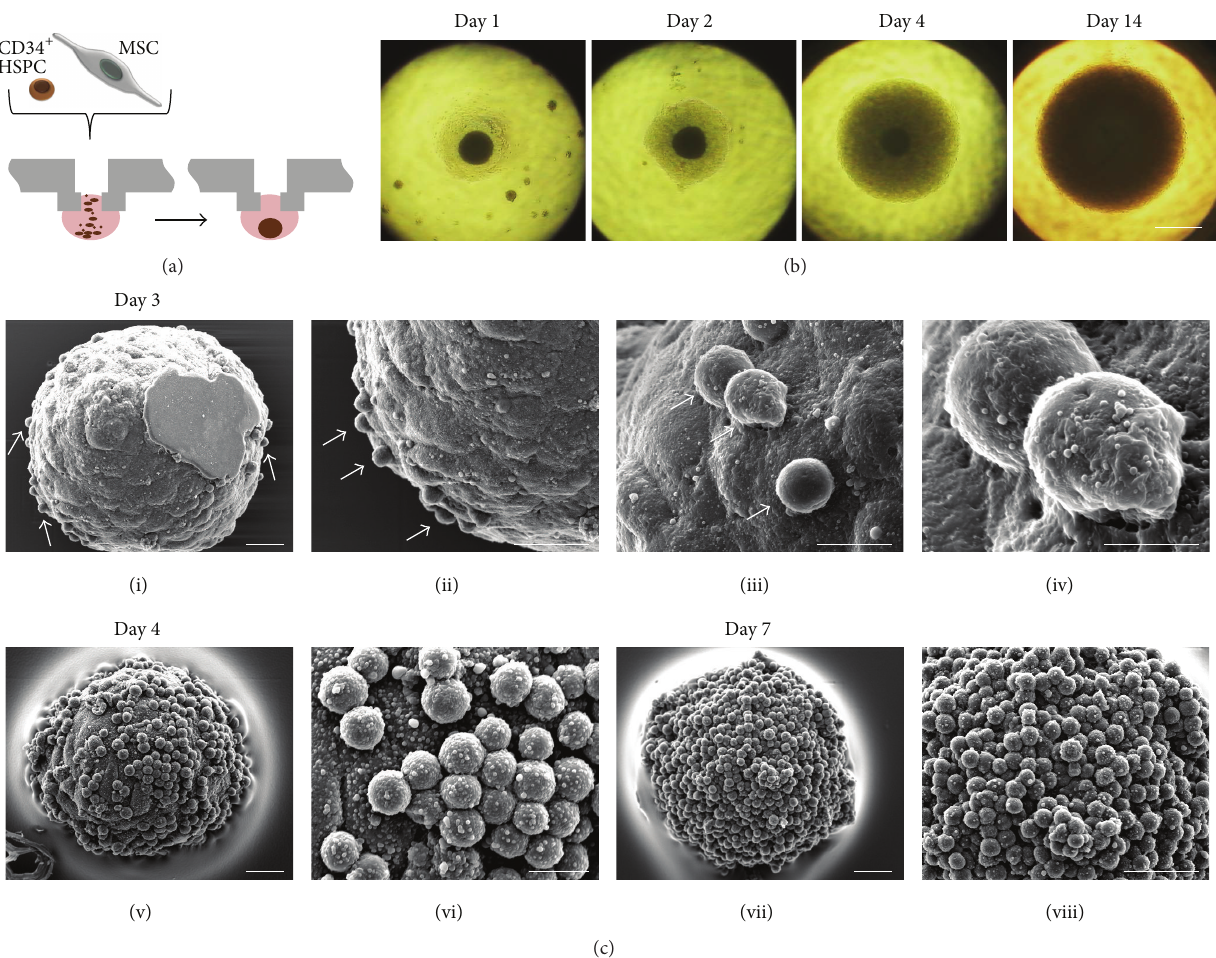
Figure 2: Attachment of CD34 + HSPCs to newly formed spheroids increases with time. (a) For coculture experiments, 5 × 10 2 CD34 + HSPCs were seeded together with 5 × 10 3 bone marrow MSCs per hanging drop and incubated for up to two weeks in GMP-SFEM-CC100 medium. (b) Light microscopy images depict the aggregation of MSCs into spheroids in the coculture as soon as one day after culture. Surrounding HSPCs expanded greatly over time. After 14 days, the cell density in the hanging drop was very high and the spheroid in the center became invisible. Scale bar: 500 𝜇 m. (c) Spheroids formed in cocultures were examined by scanning electron microscopy (SEM). A series of images from day 3 with increasing magnification (i–iv) shows a spheroid with only a few adhering HSPCs, identified as small round cells (arrows) attaching to the surface of the relatively smooth spheroid. On day 4, significantly more HSPCs attached to the spheroid (v, vi). After 7 days, the whole surface of the spheroid was covered by HSPCs, which also seem to attach to each other (vii, viii). Scale bars: 25 𝜇 m (i, ii, v, vii, and viii); 10 𝜇 m (iii, vi); and 5 𝜇 m